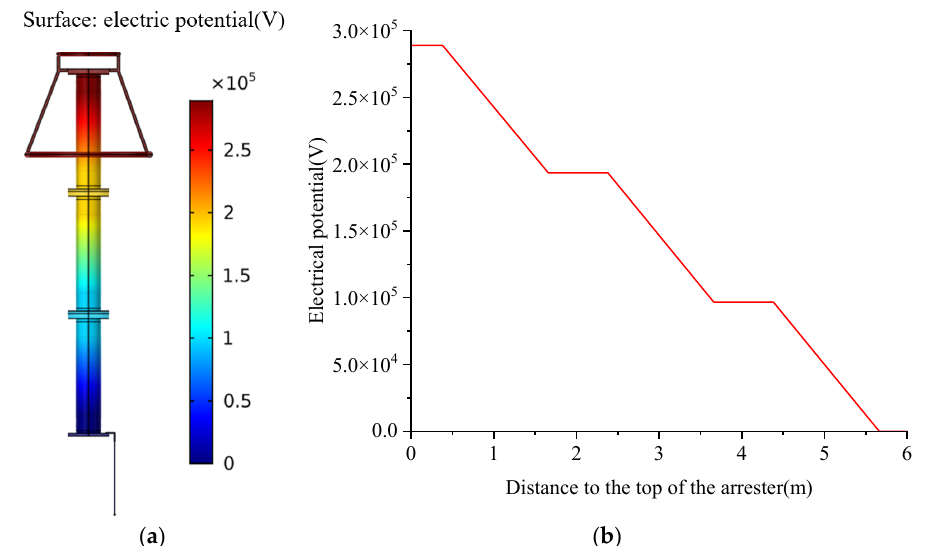
Figure 6. Potential distribution of arresters under normal conditions. ( a ) potential distribution of the